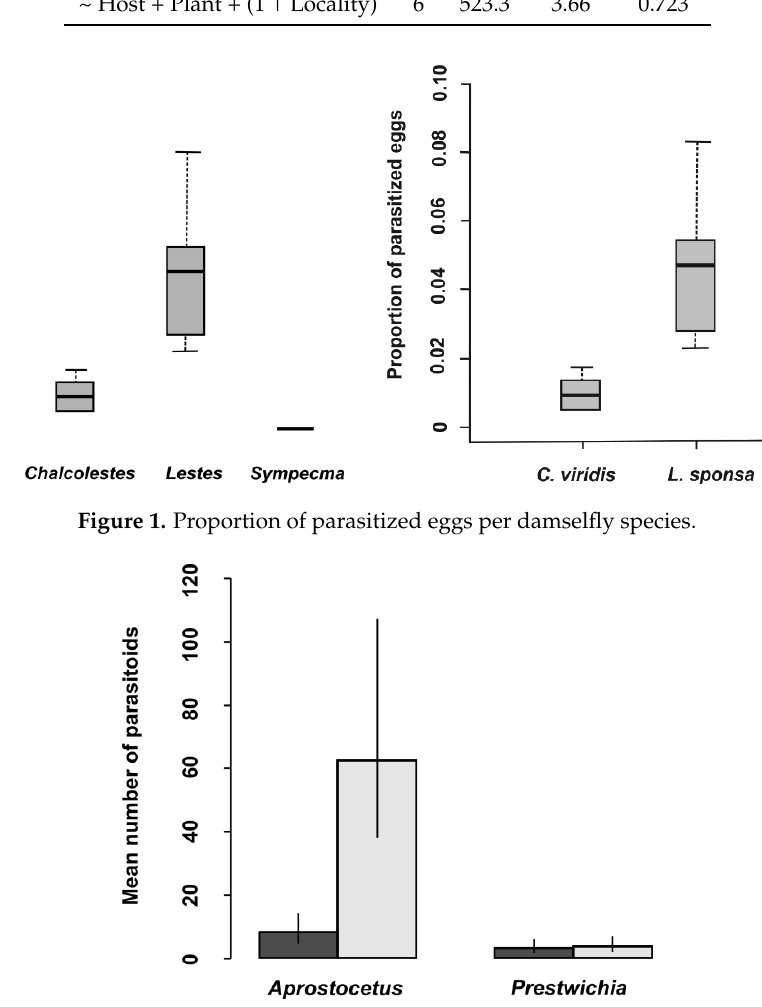
Figure 2. Mean number of parasitoids in Lestes sponsa (light) and Chalcolestes viridis (dark) eggs, with 95% confidence intervals.